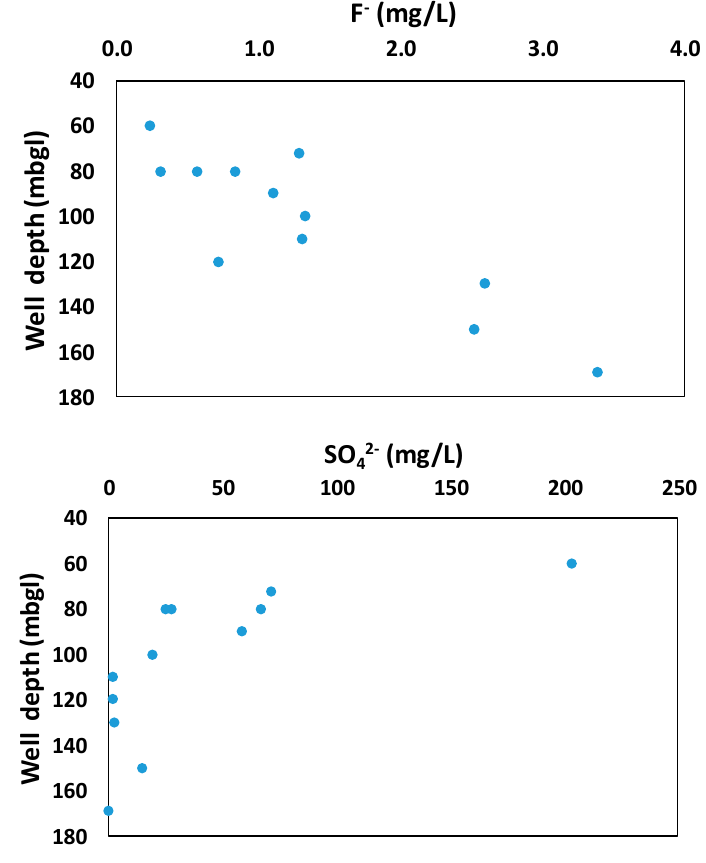
Figure 6. Scatter plot showing depth profile for F − and SO 42 − .